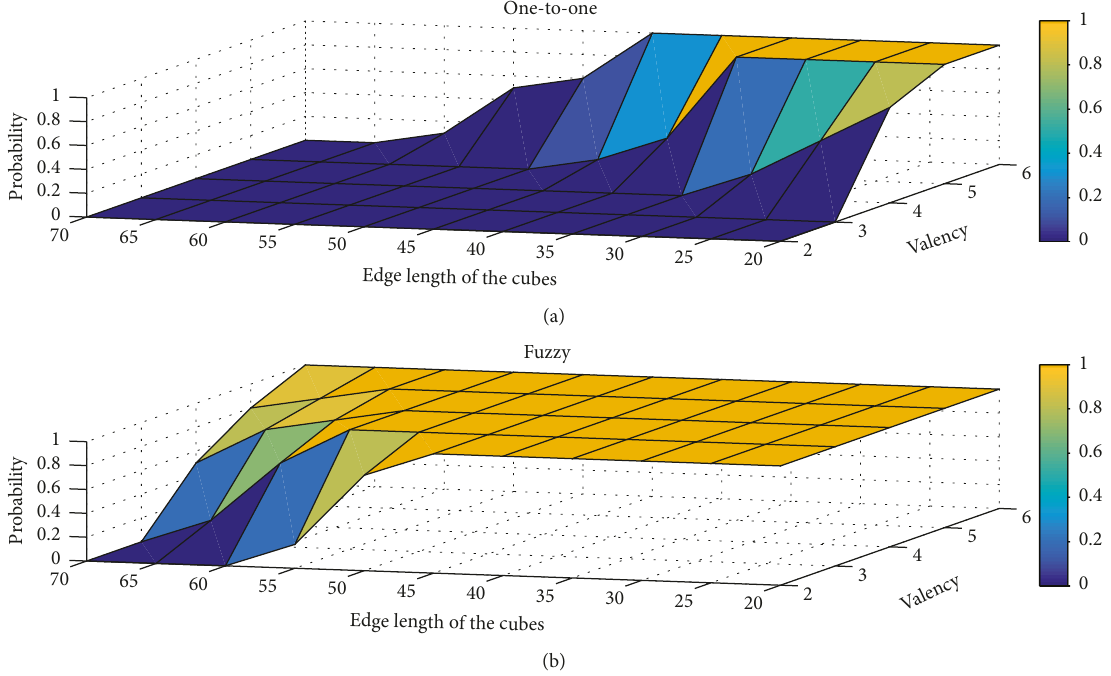
Figure 2: Probability of large polymers as a function of valency and length of the simulation box (in residue units) in one-to-one (a) and fuzzy (b) binding models. Valency is de fi ned as the number of binding elements. Concentration is the number of molecules/volume (L 3 ). Binding element a ffi nity =1.0; linker dynamics